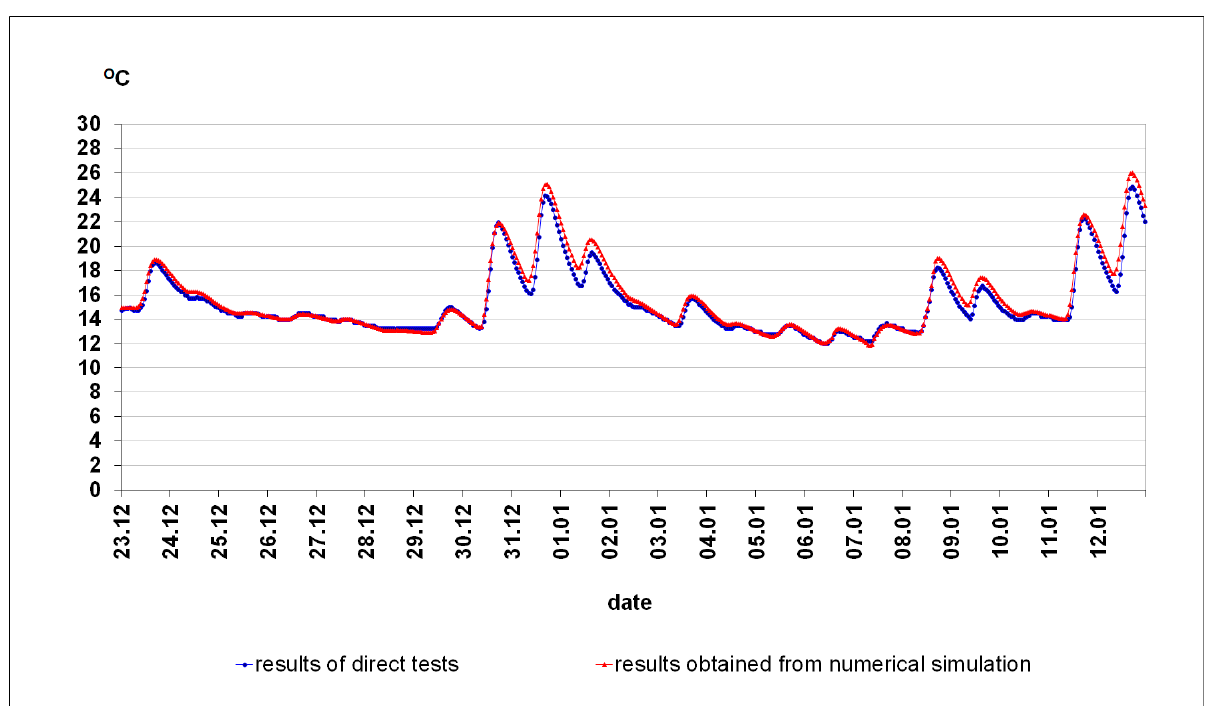
Figure 19. Graph of temperature of the absorber based on direct tests and numerical simulations.